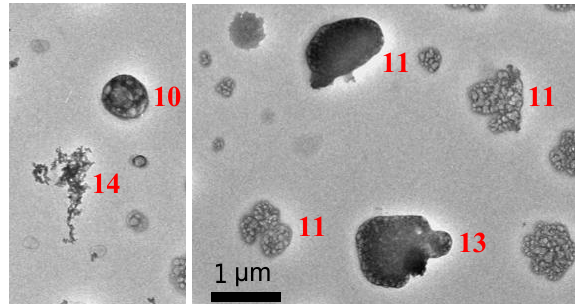
Fig. 10. TEM images of typical particle types in four size frac- tions from the Battelle sample that was collected between 11:37 and 15:05 local summer time during the episode on 25 May. The numbering of particle types is the same as in Fig. 8.